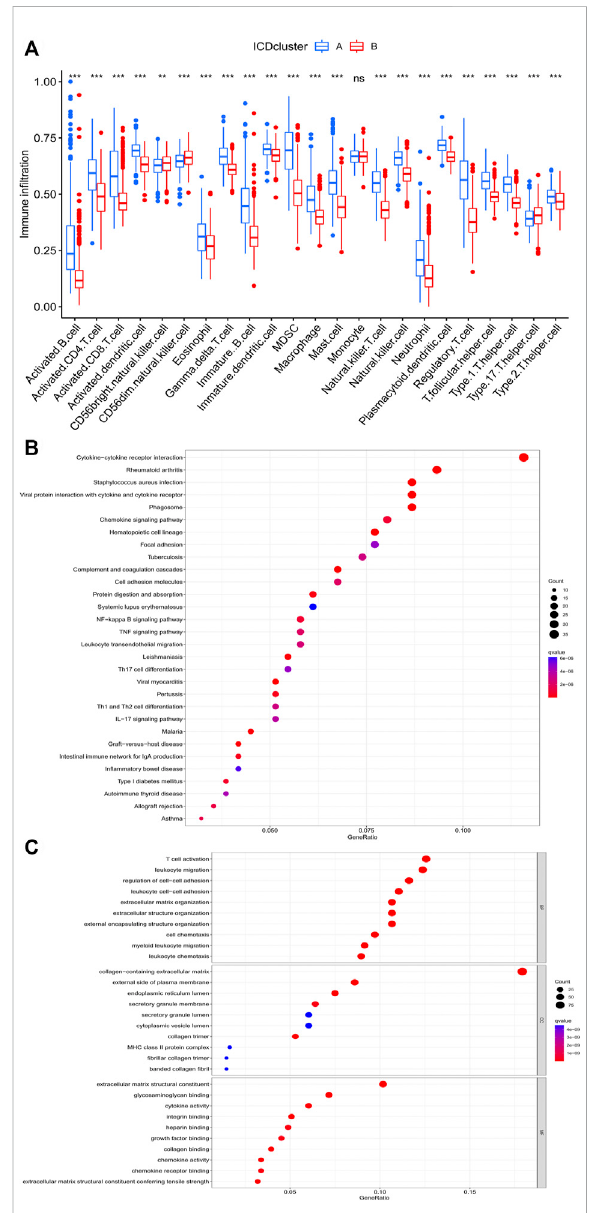
FIGURE 3 GO, KEGG and ssGSEA analyses based on DEGs in distinct ICD clusters. (A) ssGSEA analysis of two distinct ICD clusters. (B) Bubble chart presenting KEGG enrichment analysis. (C) Bubble chart presenting GO enrichment analysis. The asterisk symbol indicated the statistical p -value. (* p < 0.05; ** p < 0.01; *** p <